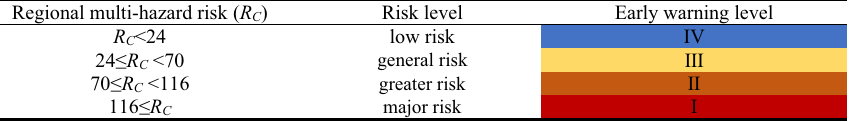
Table 6. Classification of regional multi-hazard risk